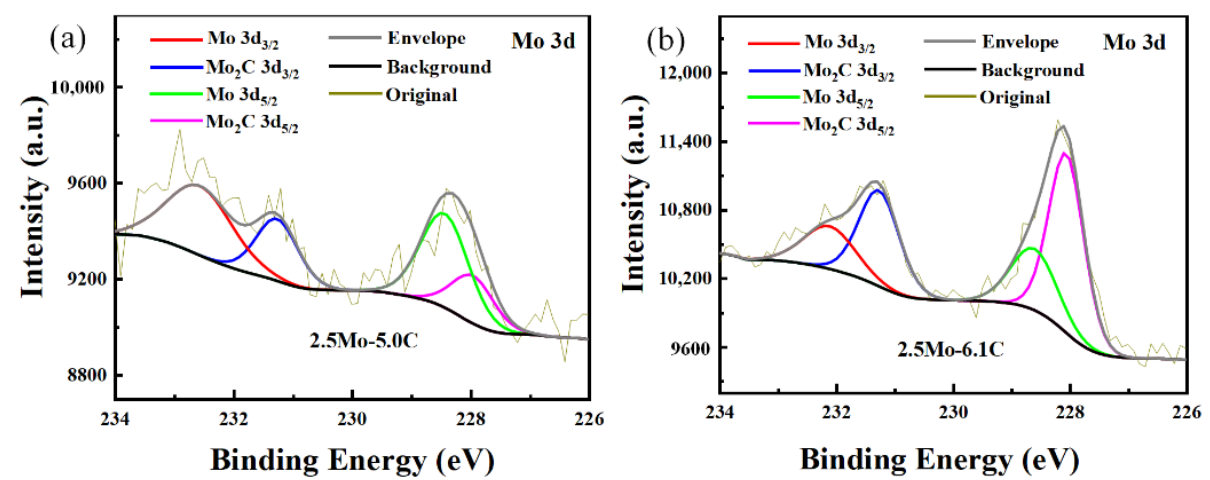
Figure 10. XPS survey spectra of 2.5Mo-5.0C ( a ) and 2.5Mo-6.1C ( b ) samples.